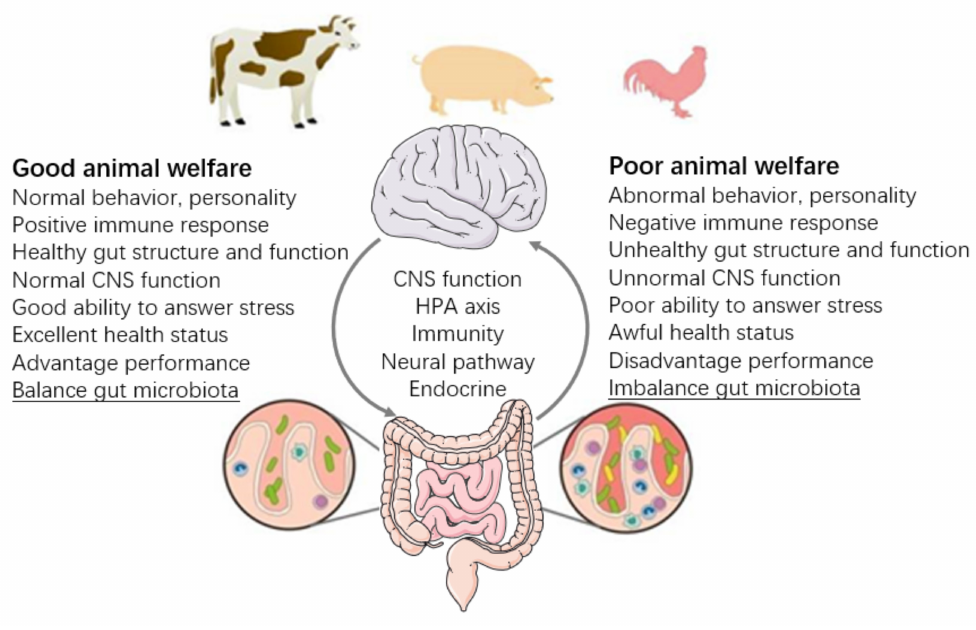
Figure 1. Animal welfare in the implication and perspective of the gut